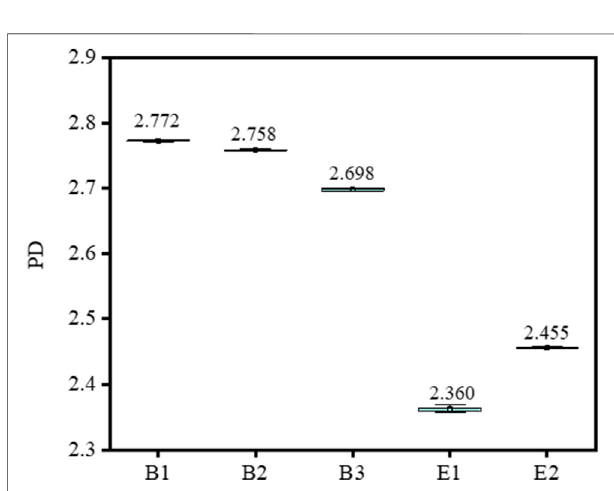
FIGURE 1 | The polydispersity (PD) of different types of